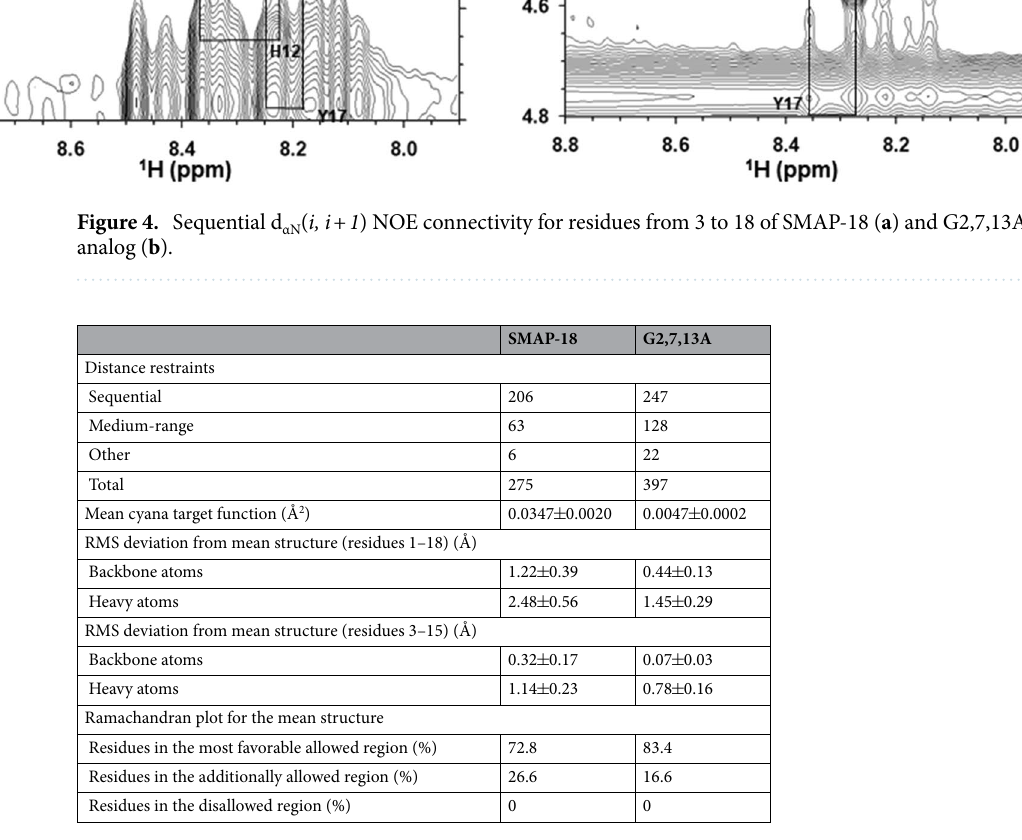
Table 4. Structural statistics for the 20 lowest-target function structures of SMAP-18 and G2,7,13A.